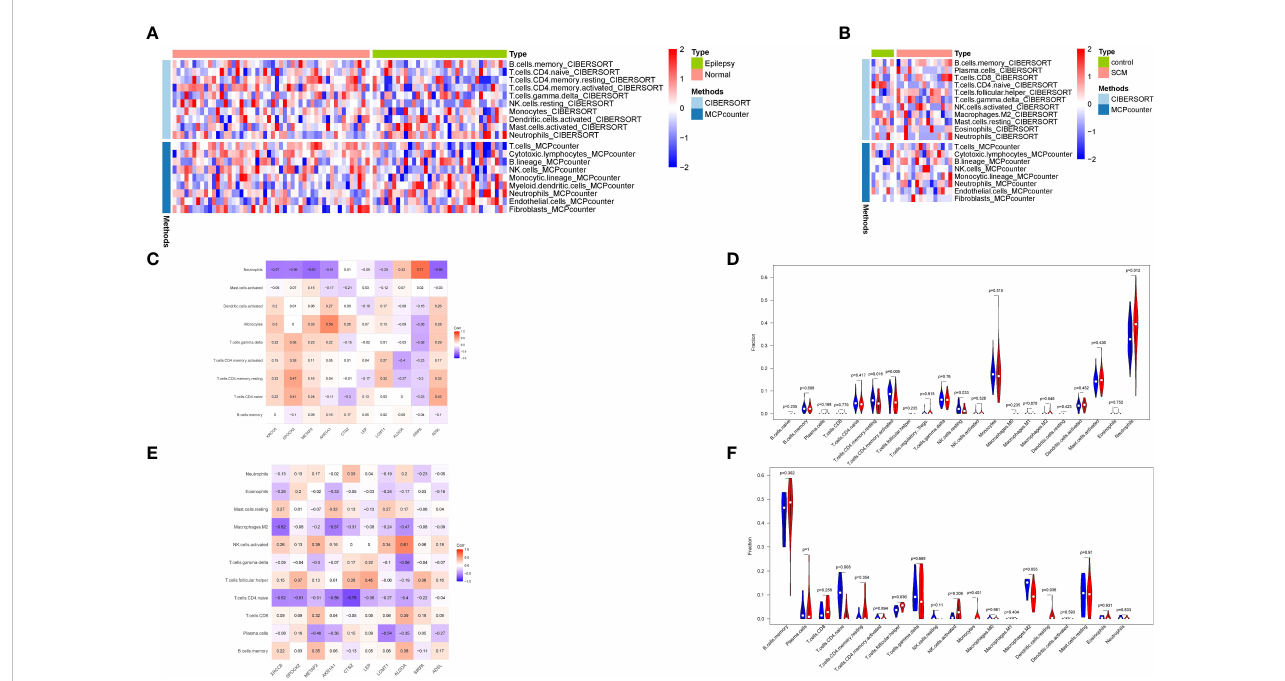
FIGURE 6 Immune in fi ltration analysis. (A) Combined analysis of CIBERSORT and MCPcounter in epilepsy. (B) Combined analysis of CIBERSORT and MCPcounter in SCM. (C) Correlation analysis of immune cells and co-expressed genes in epilepsy. (D) Wilcoxon rank-sum test of immune cells in epilepsy. (E) Correlation analysis of immune cells and co-expressed genes in SCM. (F) Wilcoxon rank-sum test of immune cells in